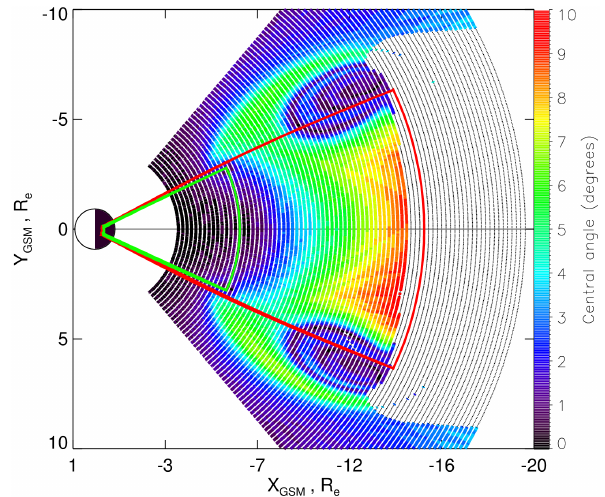
Figure 2. Magnetospheric pattern of neutral sheet footprint geo- centric angular displacement (color coded) caused by addition of the SCW2L model to the T89 + IGRF models. The SCW2L model parameters were set as follows: I 1 = 1MA, I 2 = 0.5MA, RT 1 = 15Re, RT 2 = 6Re, RCF = 6, and the wedge azimuthal width 50 ◦ .